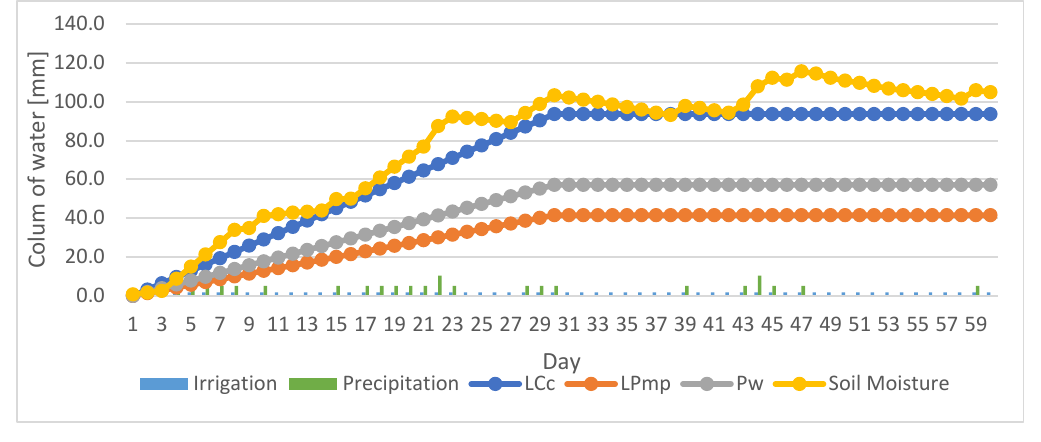
Figure 4. Moisture with traditional irrigation.